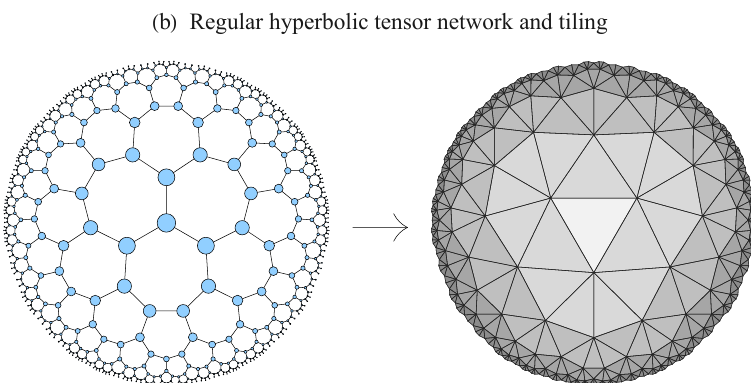
Figure 1 . The MERA and a regular hyperbolic tensor network with their corresponding tiling in the hyperbolic disk, organized into radial layers (shaded). (a) The MERA consists of two types of tensors (isometries and disentanglers, drawn here as triangles and squares) arranged in layers around a central tensor. It corresponds to an irregular, alternating triangle/quadrilateral tiling that breaks the symmetries of the hyperbolic disk but produces a smooth boundary after many layers n . (b) A regular triangular hyperbolic tensor network with one type of tensor (drawn as a circle) with the same geometrical structure around any lattice vertex, preserving a discrete subset of the symmetries of the hyperbolic disk. Unlike the MERA, the tiling has no directionality or well-defined center; however, its boundary exhibits quasiperiodic irregularity at any n